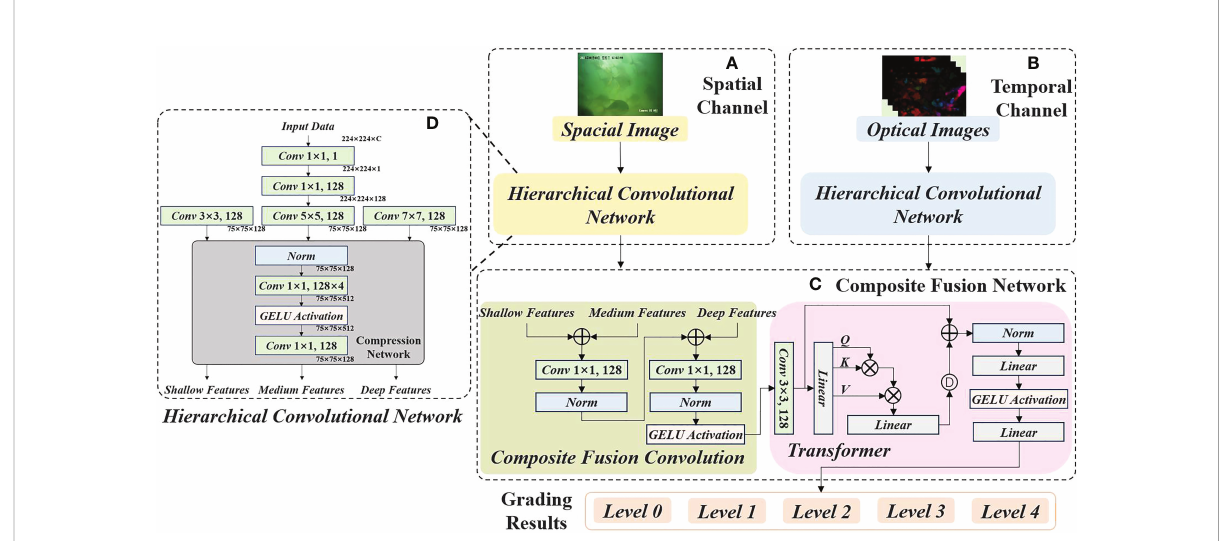
FIGURE 1 The Architecture and Stages of Dual Stream Hierarchical Transformer (DSHT). (A) is the spatial channel, and (D) is the HCN which is used to process the input and output three hierarchical feature blocks. (B) is the temporal channel which uses the similar approach with spatial channel. (C) is CFN, which is made up of CFC and